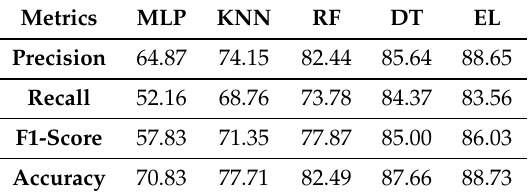
Table 5. Average cross validation score of each model (20-min prediction validity with a 60% threshold). Metrics MLP